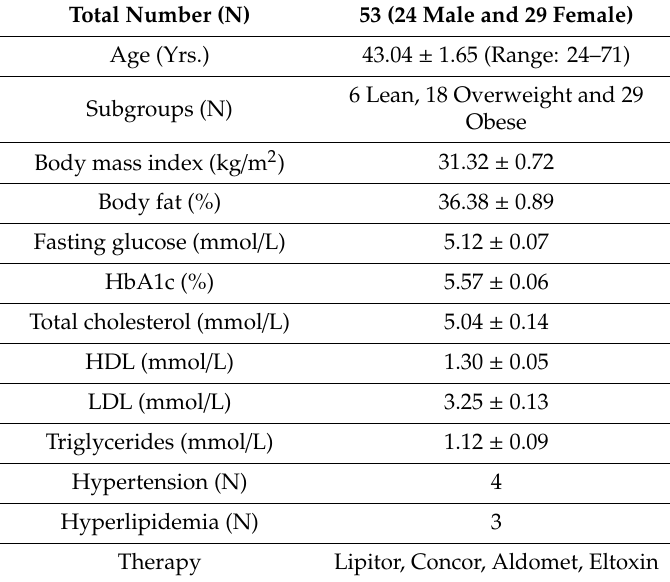
Table 1. Patients’ clinical